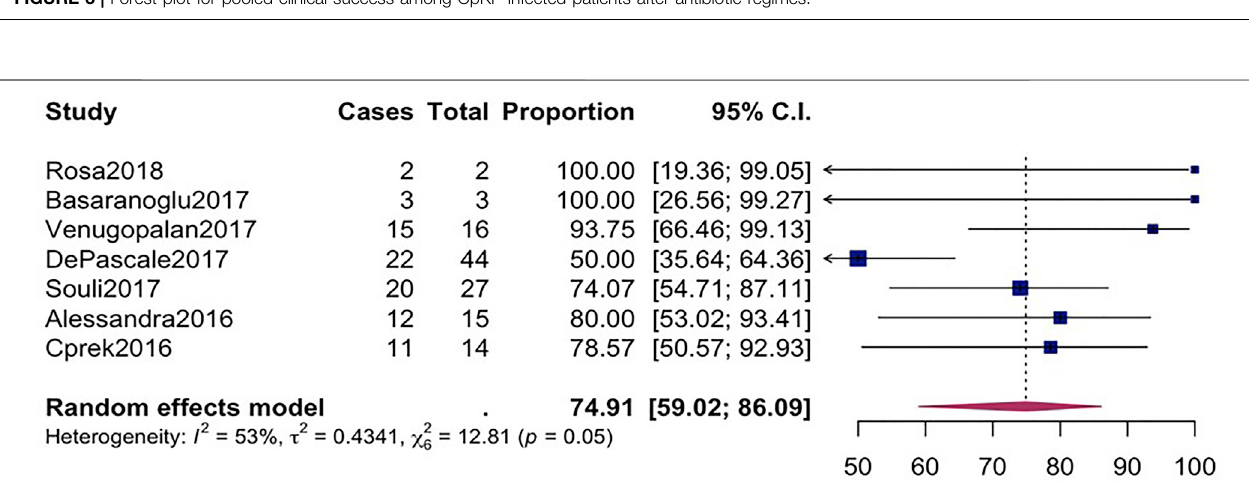
FIGURE 4 | Forest plot for pooled microbiological success among CpKP infected patients after antibiotic.